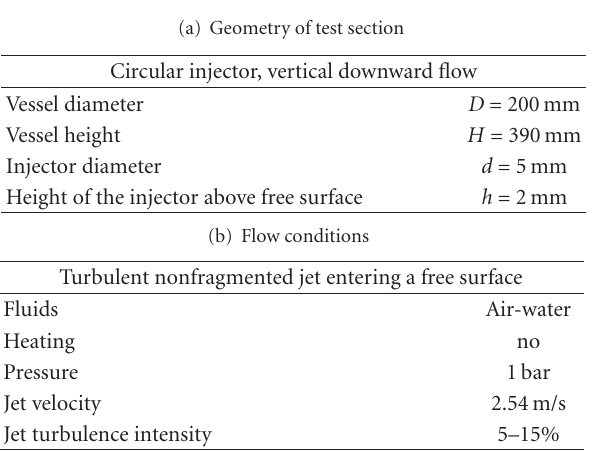
Table 1: Geometry and flow conditions.